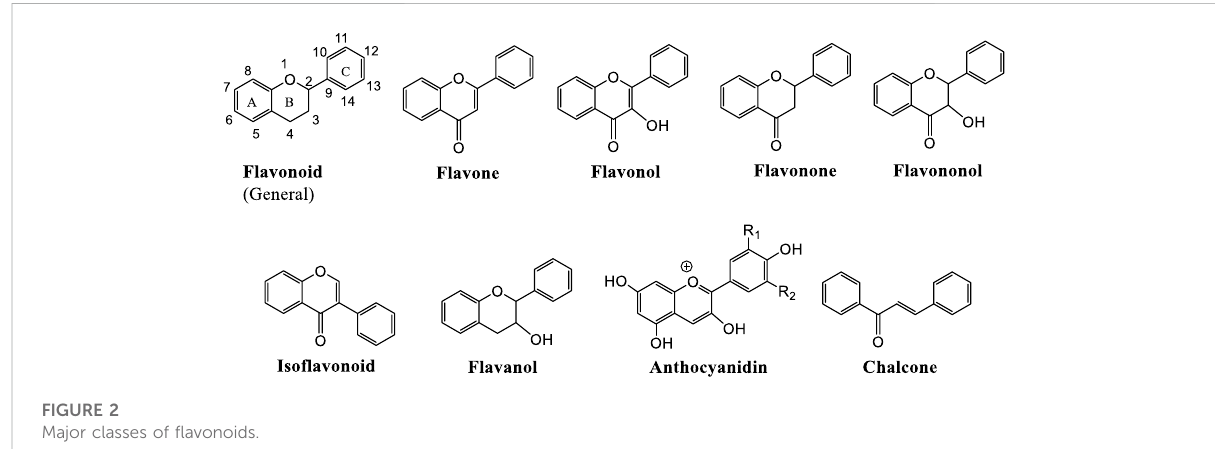
Major classes of fl